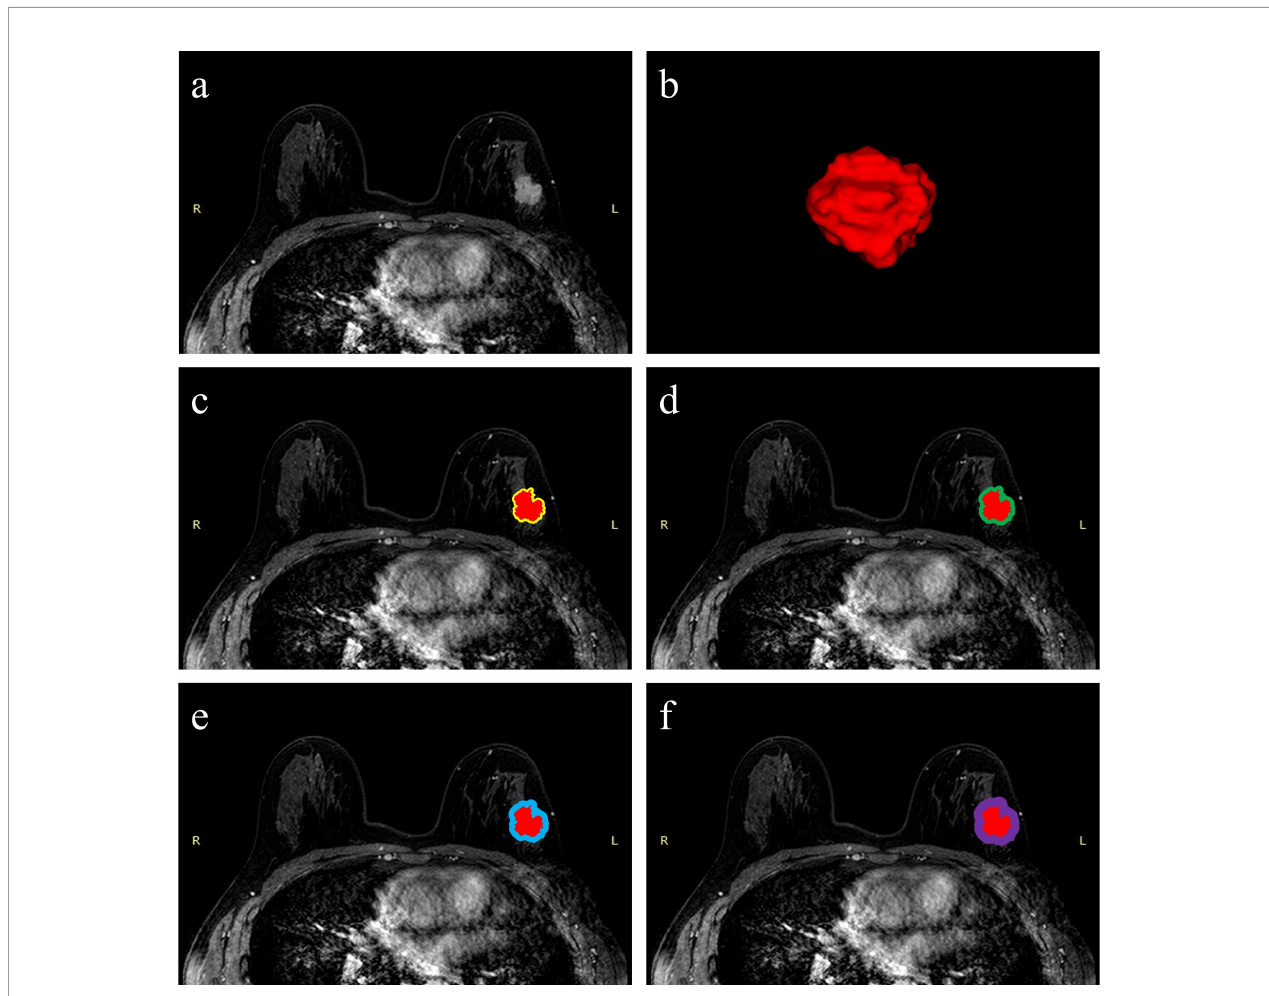
FIGURE 2 | Schematic illustration of intratumoral and peritumoral ROI segmentation. The example segmentation is from Center 1, a 47-year-old woman diagnosed with a left-sided IDBC, 29 mm, Luminal B (HER2-positive). (A) Maximal cross-sectional of tumor on the fi rst phase DCE-MRI image. (B) The 3D visualization intratumoral ROI with layer-by-layer delineation. (C – F) The red masks are the intratumoral ROIs, and the peritumoral ROIs are annular masks that automatically shape-modulated the intratumoral ROIs with sizes of 2 mm (yellow), 4 mm (green), 6 mm (blue), and 8 mm